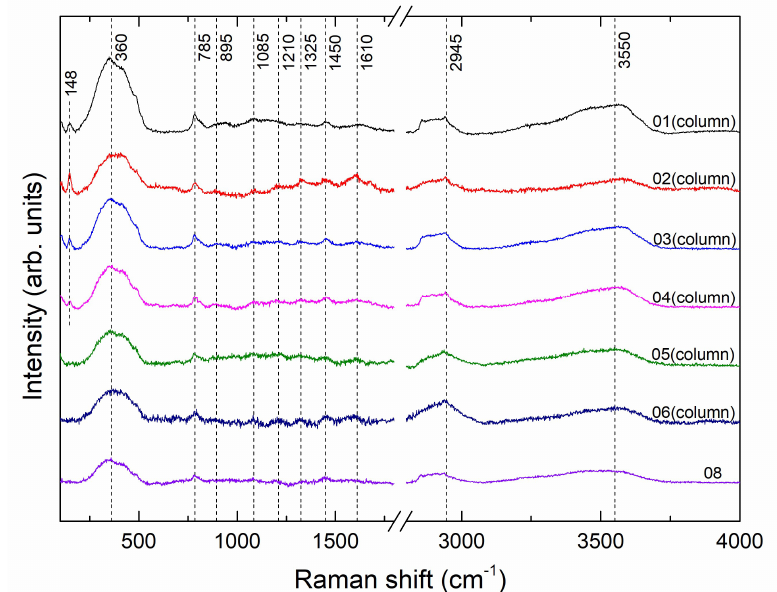
Figure 9. Raman spectra in the range of 100–4000 cm − 1 of opals from Wegel Tena, Ethiopia. Each sample shows a main band at around 360 cm − 1 , several small bands in the range of 750–1650 cm − 1 , as well as broad bands around 2945 cm − 1 and 3550 cm − 1 . Opals 01 to 04 show a sharp band at 148 cm − 1 , which is related to